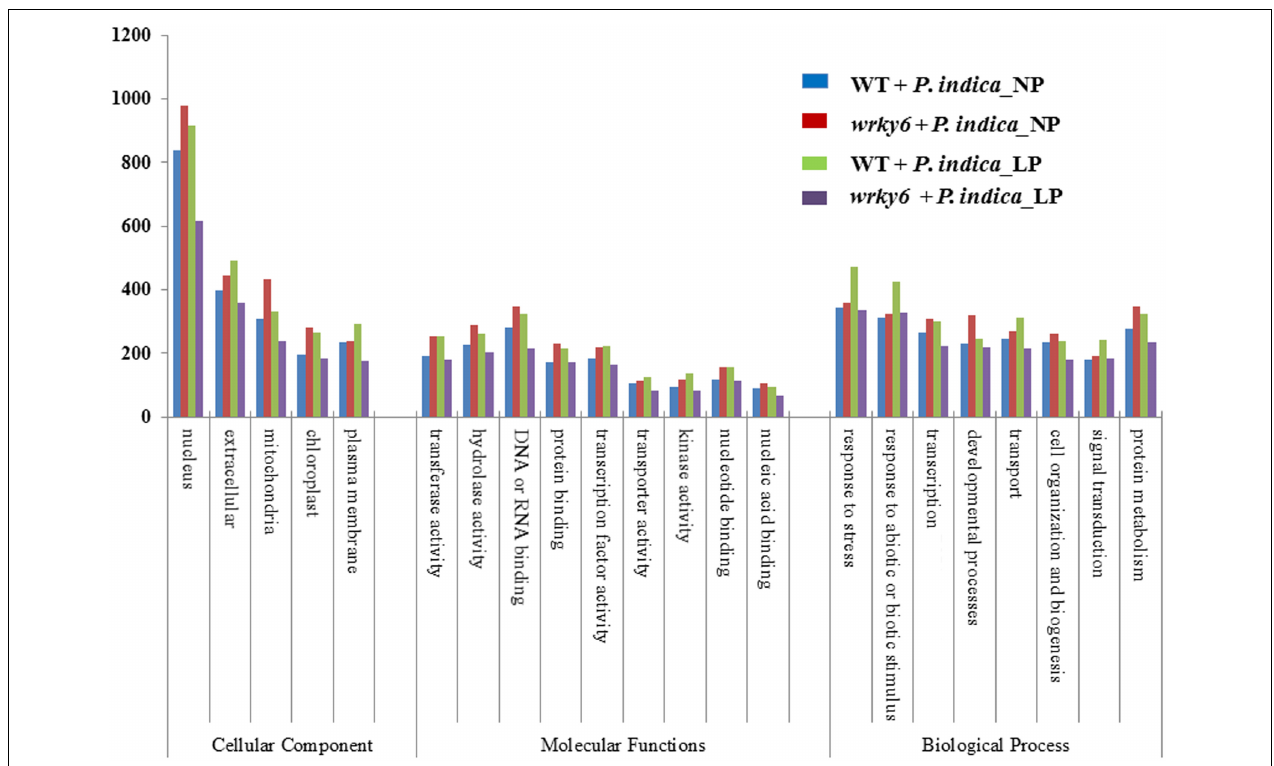
FIGURE 3 | GO annotations of the genes which are differentially regulated ( > 2-fold) by P. indica in WT or wrky6 roots grown on either NP or LP. For specific genes, see data submitted to NCBI.